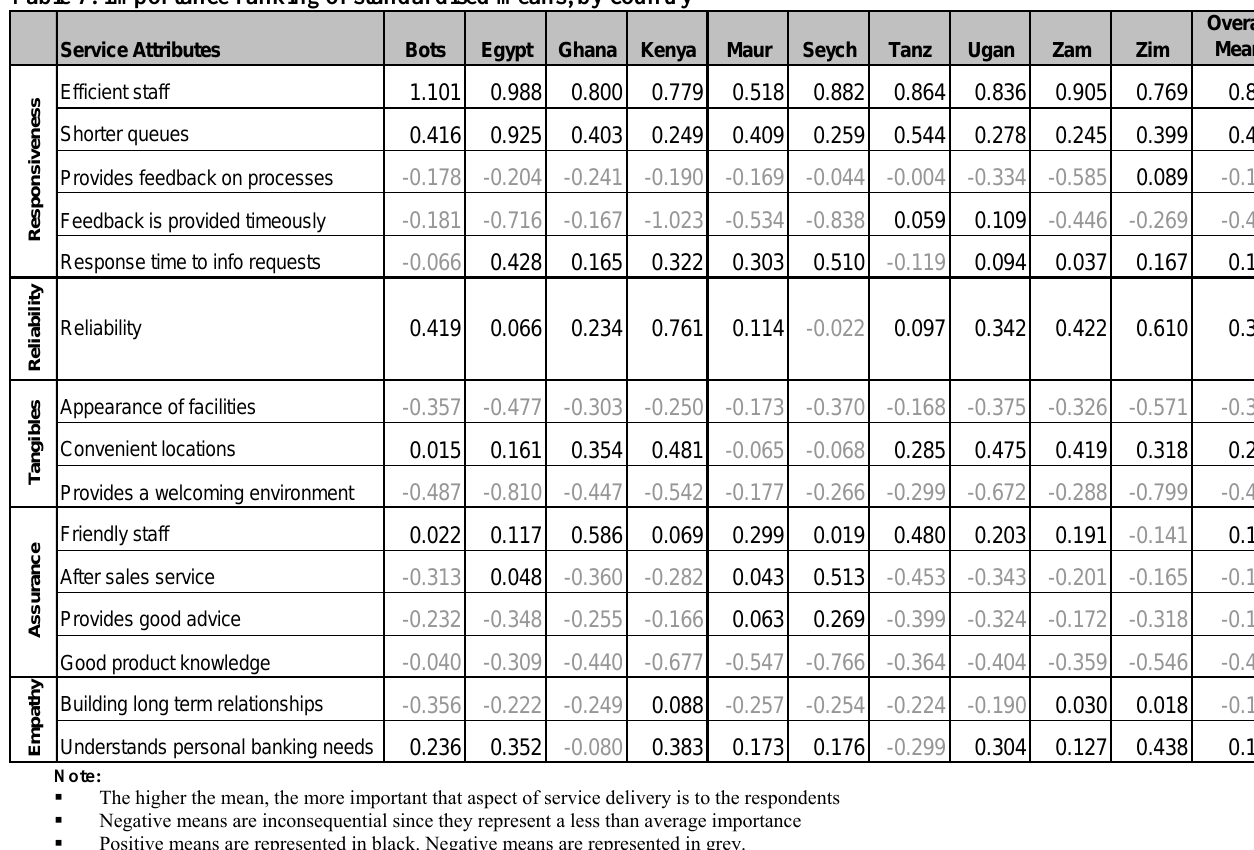
Table 7: Importance ranking of standardised means, by country